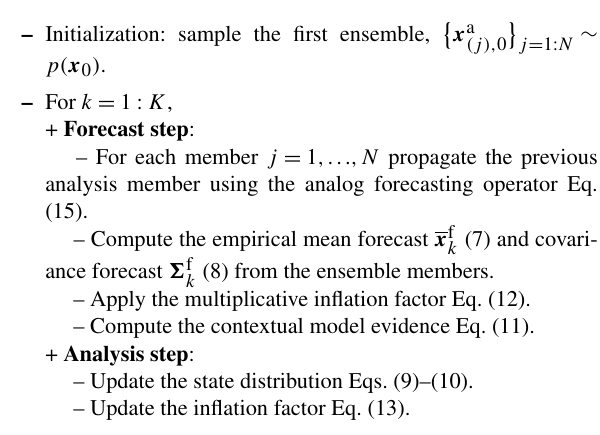
Algorithm 1 Contextual model evidence using EnKF and lo- cal linear regression